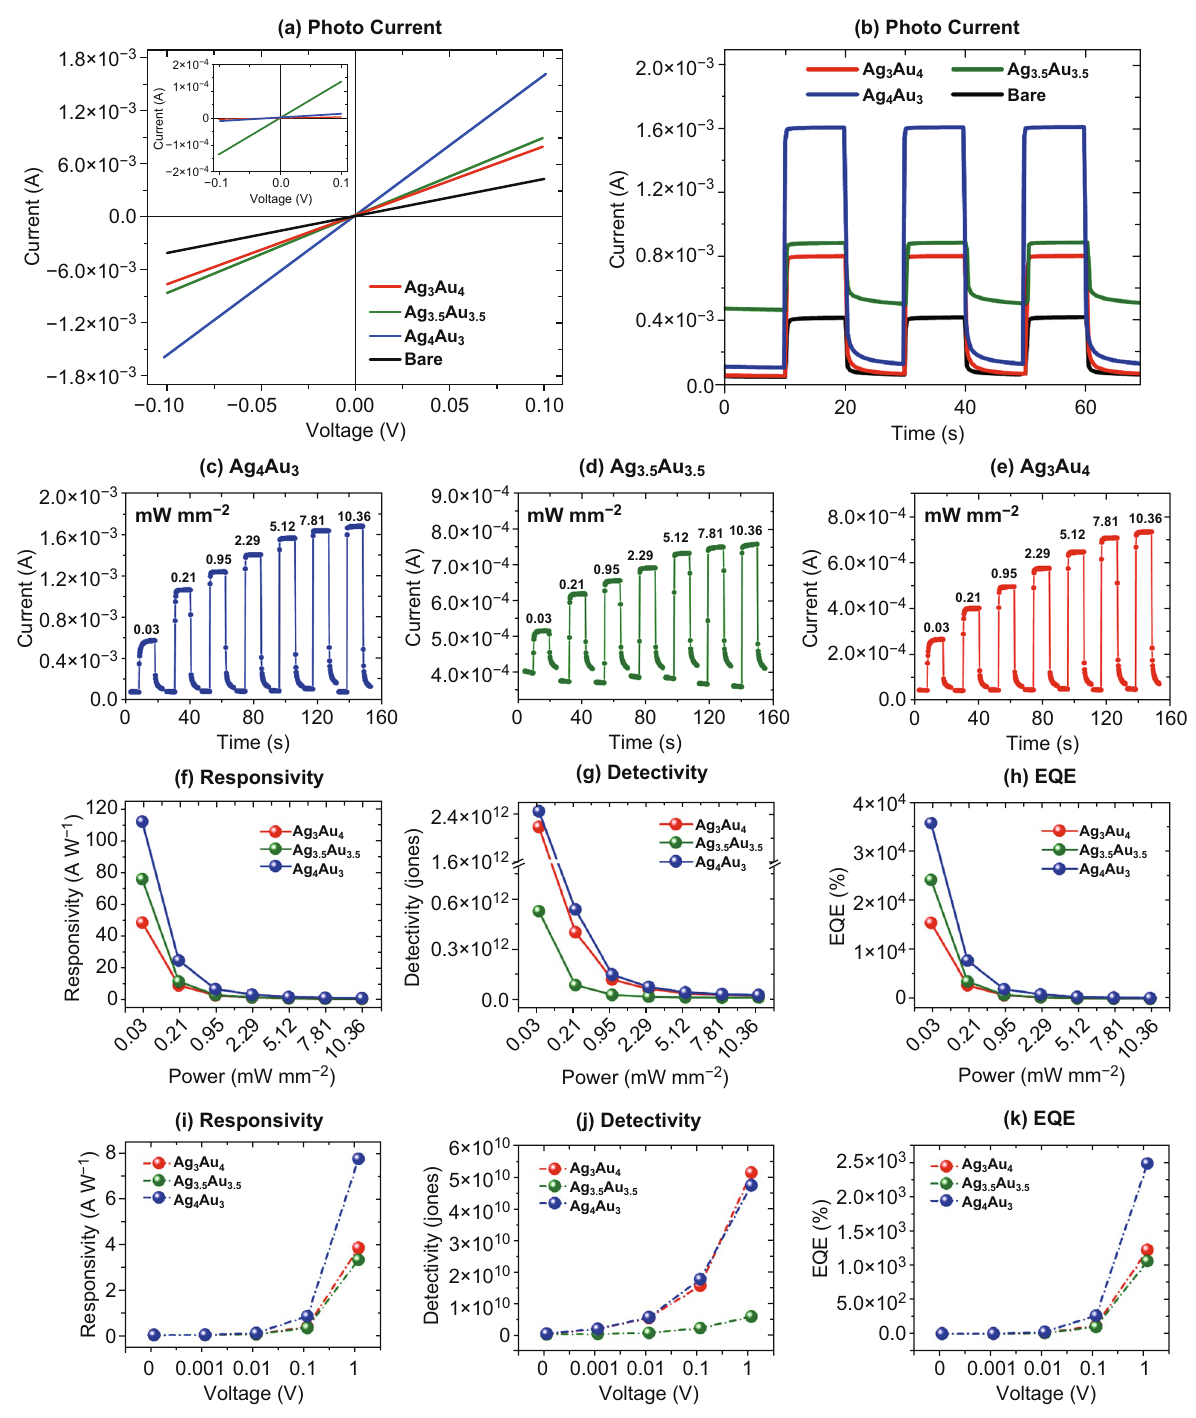
Fig. 5 Photoresponse enhancement of UV photodetectors by the various AgAu alloy NPs under 385 nm UV illumination. a I–V characteristic under UV illumination and dark for different devices. b Time‑resolved photocurrent response at 0.1 V. c – e Light intensity‑dependent photore‑ sponse of the devices. f – h Summary of the R, D , and EQE as a function of photon power at a constant bias of 0.1 V. i – k Summary of the R, D , and EQE as a function of voltage at a constant power of 10.36 mW mm